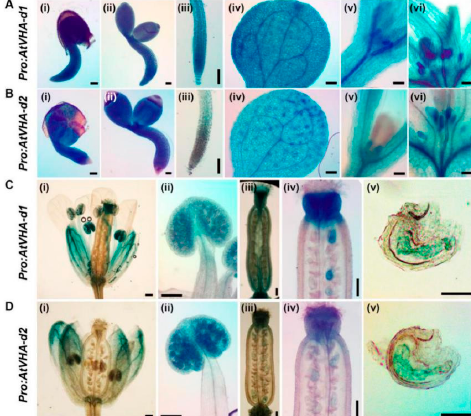
Figure 2. AtVHA-d1 and AtVHA-d2 gene promoter-GUS expression in Arabidopsis. Histochemical GUS staining was carried out at different development stages and in various tissues of AtVHA-d1 and AtVHA-d2 genes promoter-GUS transgenic Arabidopsis plants. ProAtVHA-d1:GUS ( A ) and ProAtVHA-d2:GUS ( B ) expression in all tissues of the seedlings (i and ii), root (iii), leaf (iv), and stipule primordia (v and vi); ProAtVHA-d1:GUS ( C ) and ProAtVHA-d2:GUS ( D ) expression in the sepal (i), anther (ii), base and top of the silique (iii and iv), and embryo sac (v). Scale bar = 200 µ